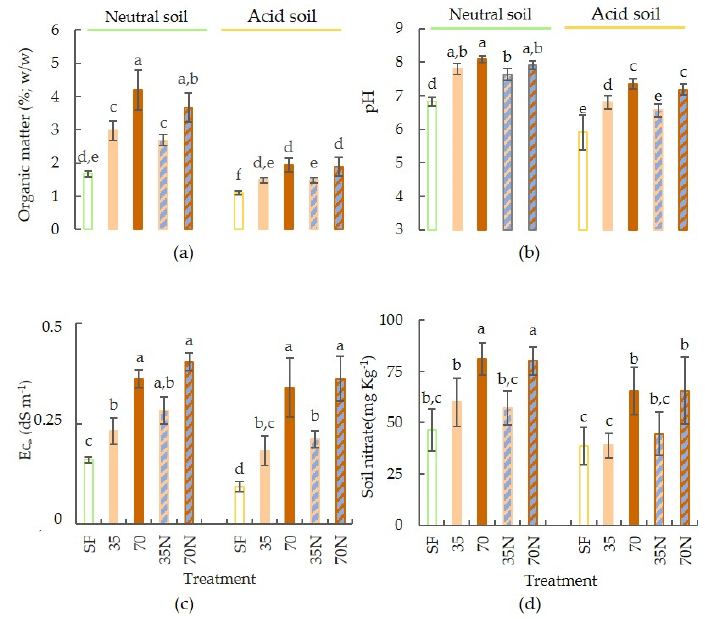
Figure 3. Effects of soil and MSWC supplemented or not with inorganic nitrogen on soil organic matter ( a ), pH ( b ), EC e ( c ) and nitrate ( d ) values. Note: FS—fertilized soil; 35—35 t MSWC ha − 1 ; 70—70 t MSWC ha − 1 ; 35 + N—35 t MSWC ha − 1 + 92 kg N ha − 1 ; 70 + N—70 t MSWC ha − 1 + 92 kg N ha − 1 . Means with different letters are significantly different at p < 0.05. Each bar represents the mean of six replicates, and the error bars represent ±1SE.